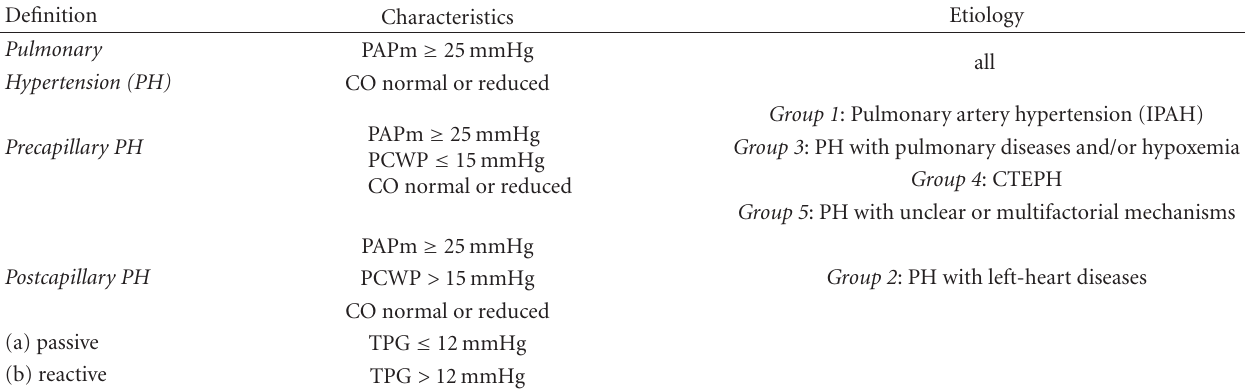
Table 2: Hemodynamic characteristics in patients with pulmonary hypertension (mod. [8]).